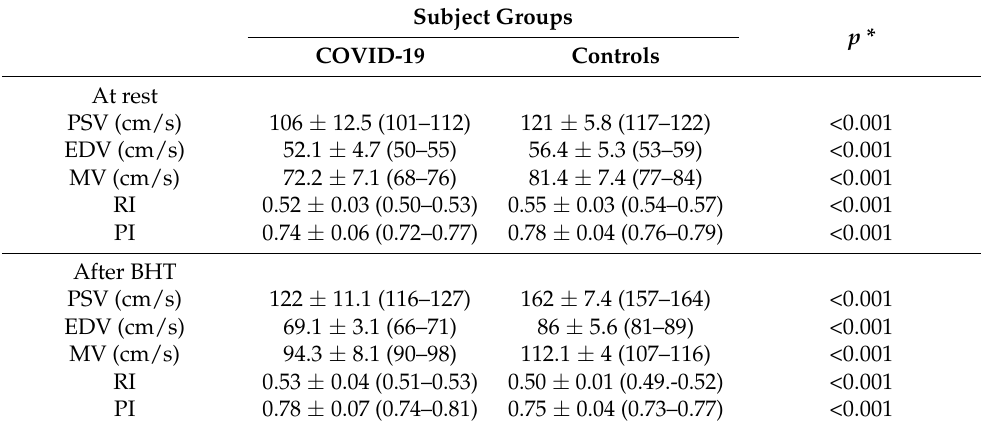
Table 7. Median (Q1-Q3) presentation of changes in flow velocities rates through MCA after BHT and rest period in relation to groups of subjects. Subjects Groups COVID-19